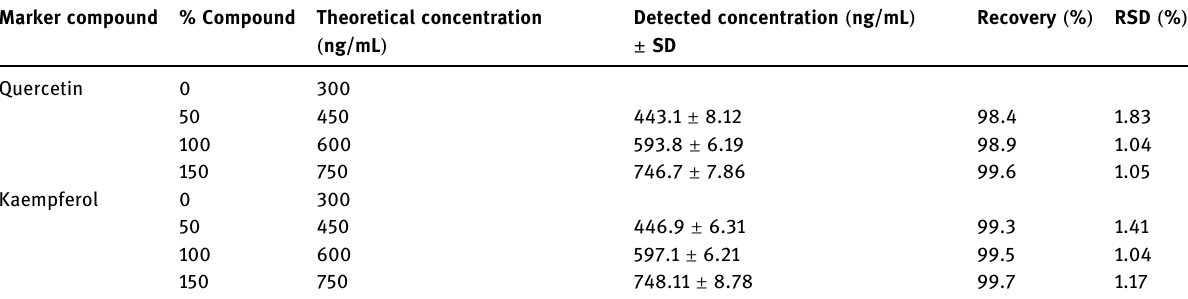
Table 6: Recovery studies of quercetin and kaempferol Marker compound % Compound Theoretical concentration ( ng/mL